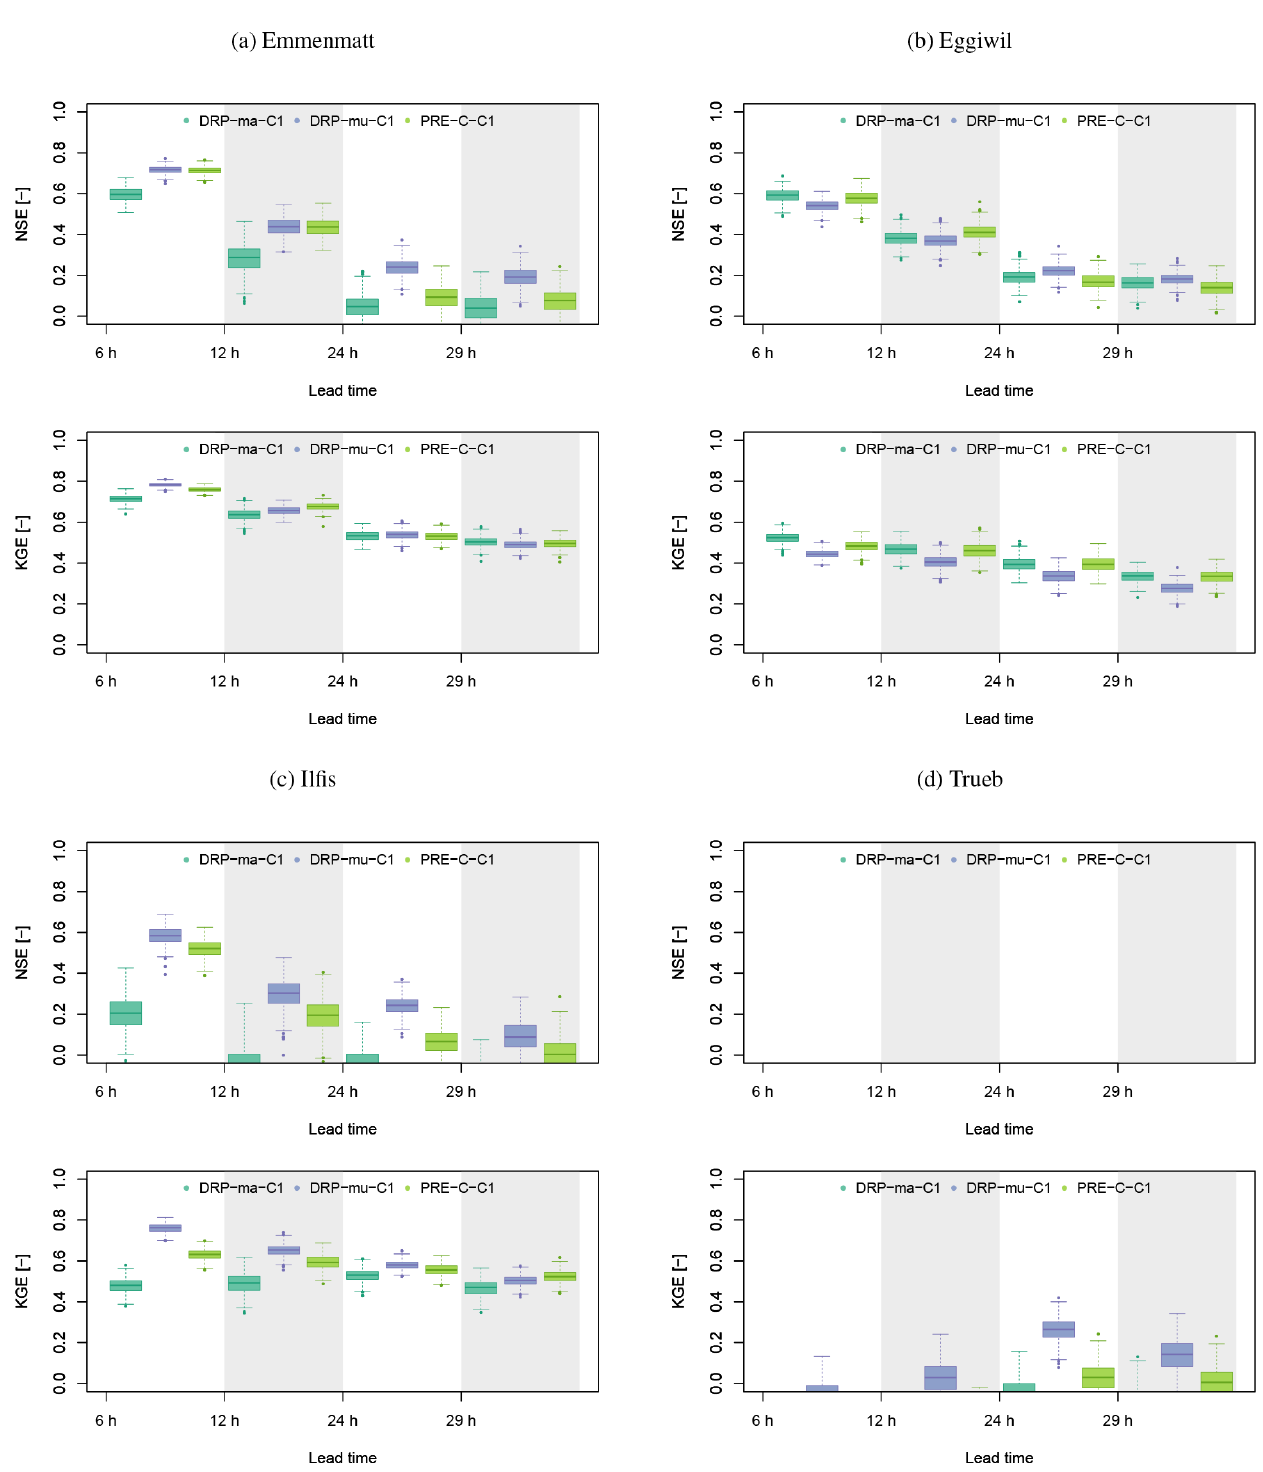
Figure 7. NSE and KGE for (a) Emmenmatt, (b) Eggiwil, (c) Ilfis and (d) Trueb as a function of lead time for DRP-ma-C1 (dark green), DRP-mu-C1 (blue) and PRE-C-C1 (light green) for all events in the investigated period from May until July 2016. A window of 6h was taken for the computations, e.g. from 19 to 24h for the 24h lead time. The box plots represent the sampling uncertainties of the score computations obtained with bootstrapping (Addor et al.,